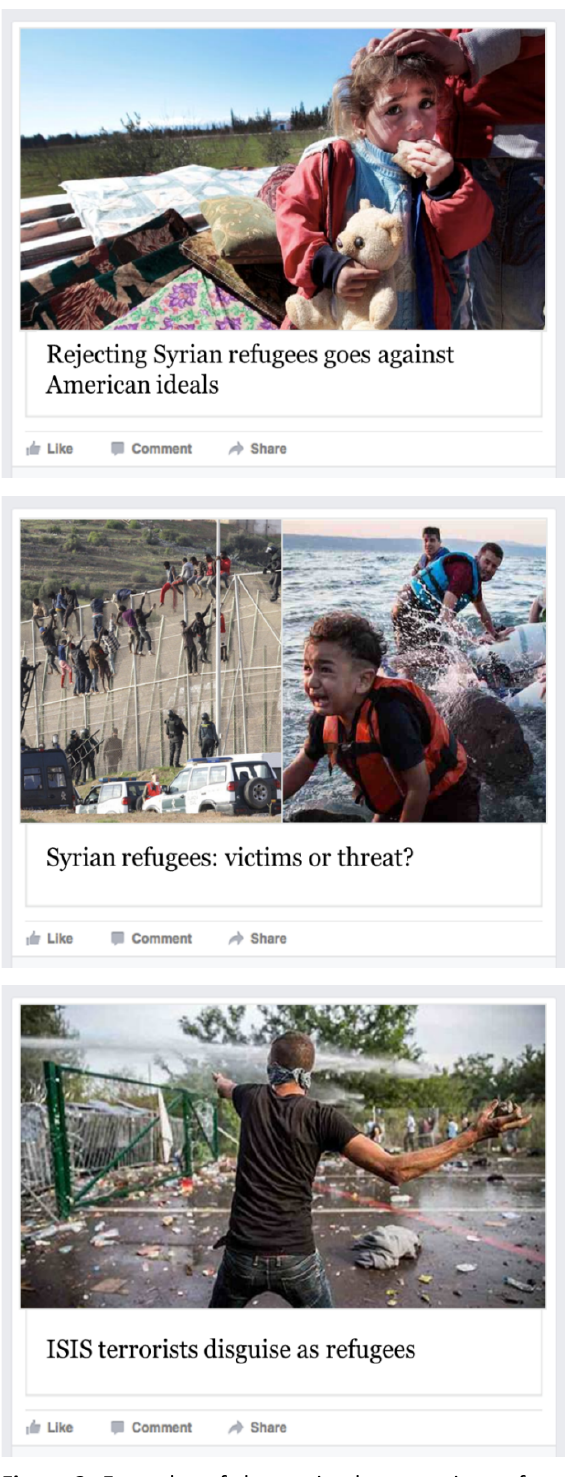
Figure 2. Examples of three stimulus news items from Study 1, for the refugee context, without sources. Notes: matching image-headline pairs are shown for the pro- (top), balanced (middle) and anti-refugee (bottom) con- ditions. In total the stimulus newsfeed contained nine im- migrations news items, comprising all possible matching and non-matching image-headline pairings.